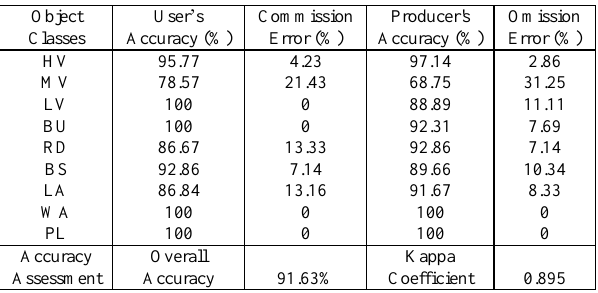
Table 3. The error statistics and overall